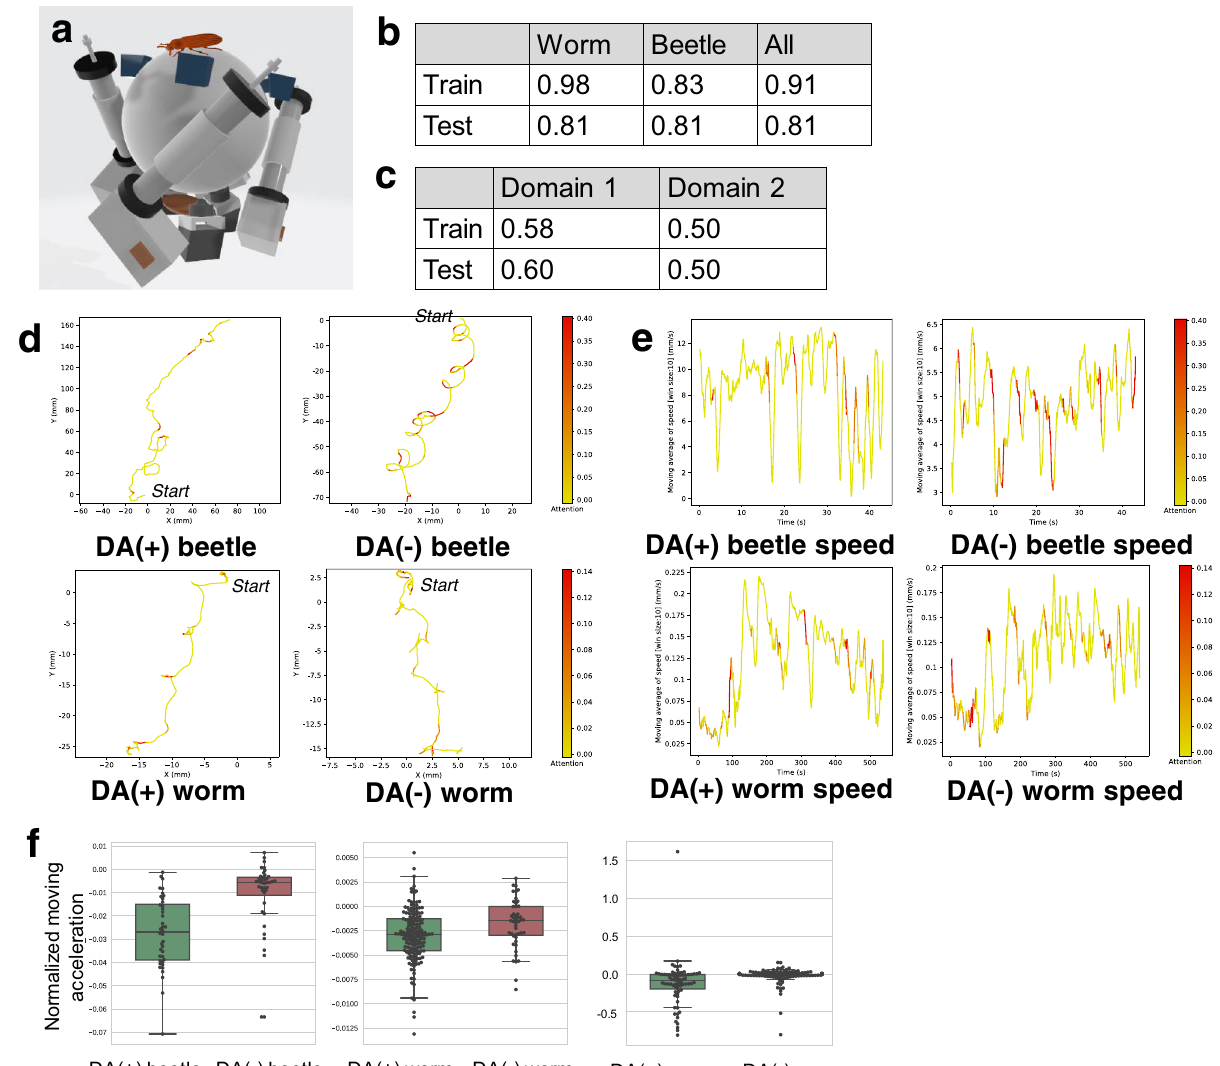
Fig. 4 Analysis of DA( + )/DA( − ) beetles and worms. (DA: dopamine). a Experimental apparatus for beetle study (treadmill). b Classi fi cation accuracies of our network for DA( + )/DA( − ) classes. c Classi fi cation accuracies of our network for the 1st and 2nd domain estimates; see Supplementary Information for the detailed results of the domain estimates. d Example trajectories of DA( + )/DA( − ) beetles and worms highlighted by our network. e Example time- series of speed of DA( + )/DA( − ) beetles and worms highlighted by our network. f Distributions of acceleration before turns for beetles and worms (see Supplementary Information for details); signi fi cant differences between DA( + ) and DA( − ) for both beetles and worms are observed (worm by the Brunner – Munzel test: p = 0.005; w = − 2.90; df = 72.76; effectsize = 0.36; n = 162 from DA( + ) worms; n = 47 from DA( − ) worms; beetle by